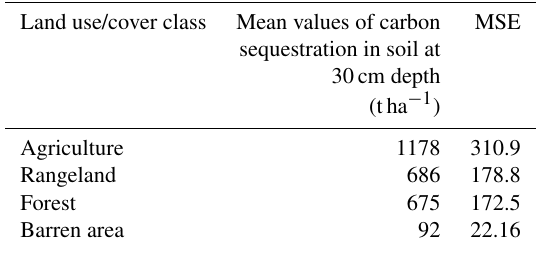
Table 6. Carbon sequestration of soil by land use/cover class.